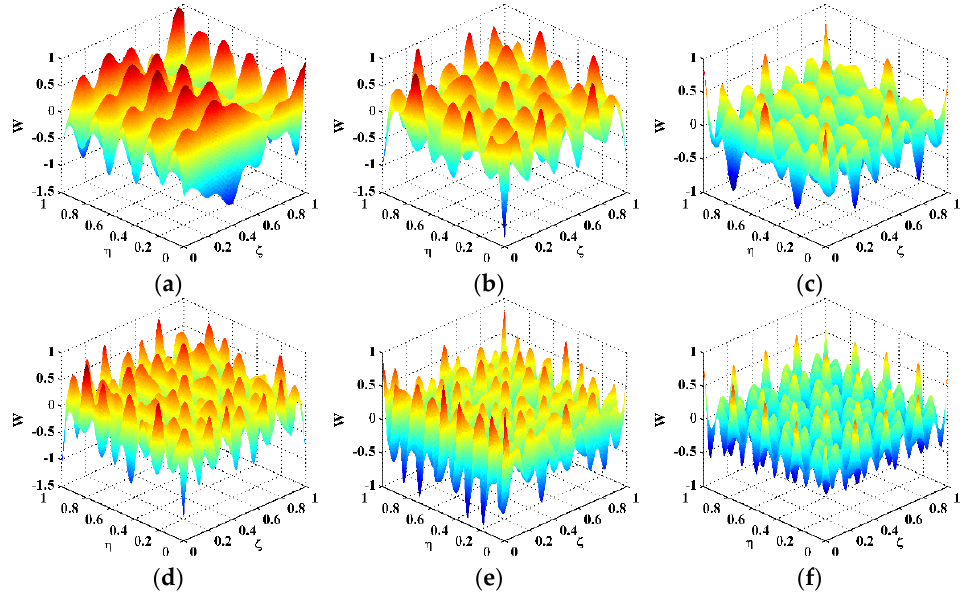
Figure 2. Mode shapes of the CFRP laminate for Scenarios ( a ) I, ( b ) II, ( c ) III, ( d ) IV, ( e ) V, and ( f ) VI.